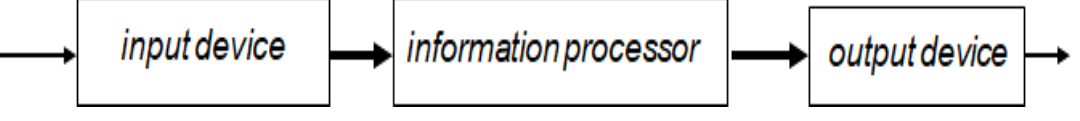
Figure 1. A schema of transducer hardware.